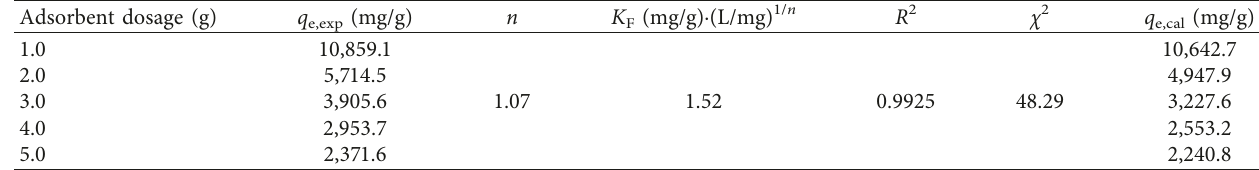
Table 3: Freundlich isotherm constants using modified bagasse using a laboratory-scale system. Adsorbent dosage (g)